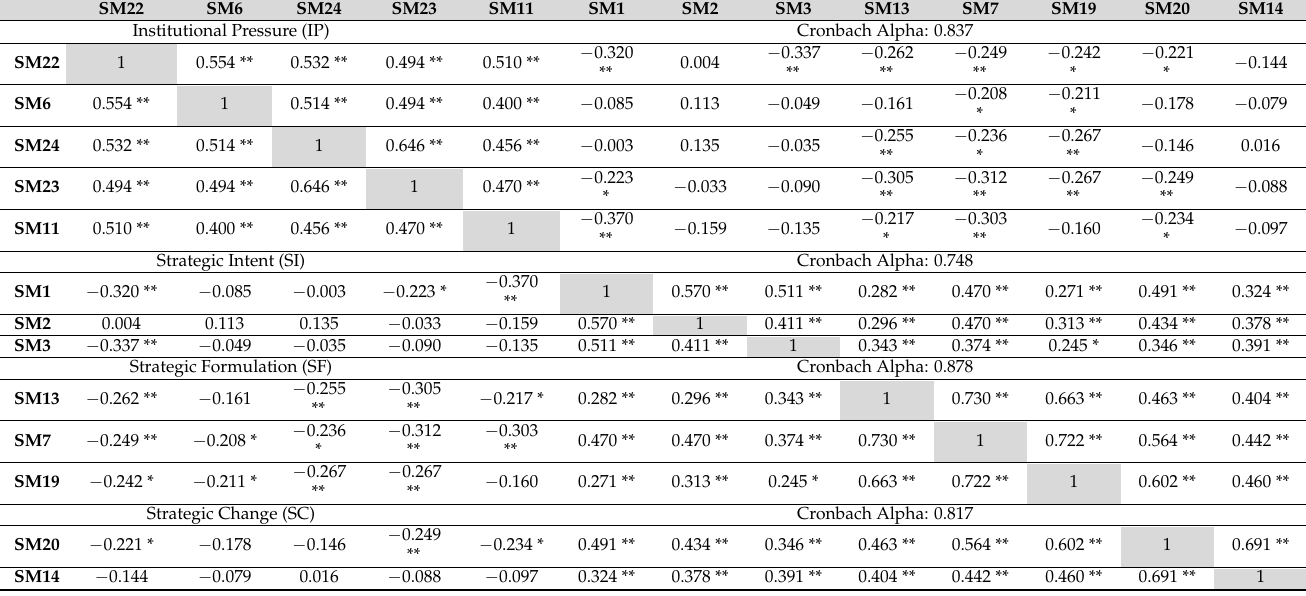
Table 6. Correlation matrix and Cronbach Alpha of final model